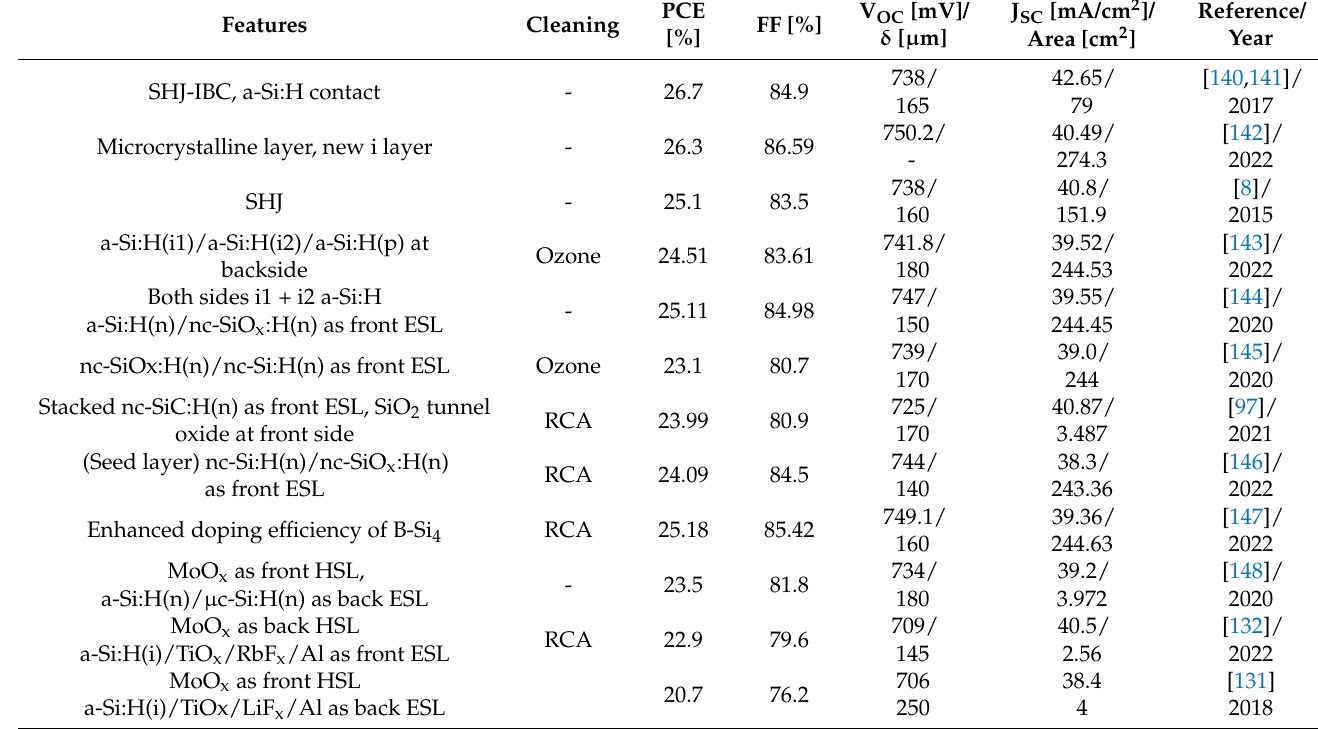
Table 1. Performance, contact features and cleaning methods of high-efficiency SHJ solar